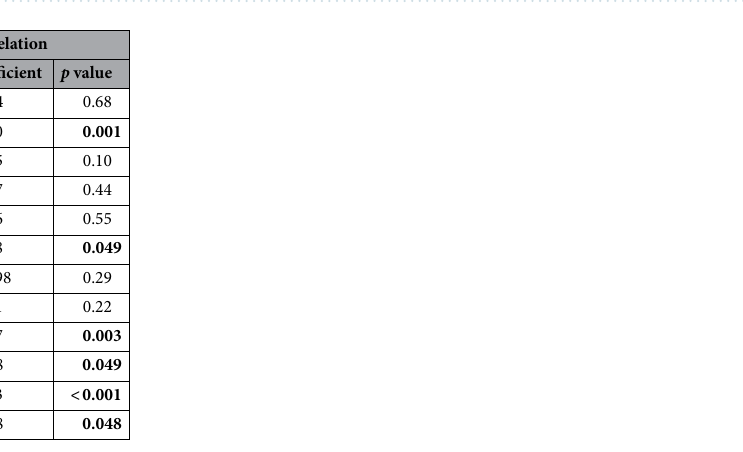
Table 3. Univariate correlations between FKBPL and other clinical parameters in diabetes. p values <0.05 are in bold.